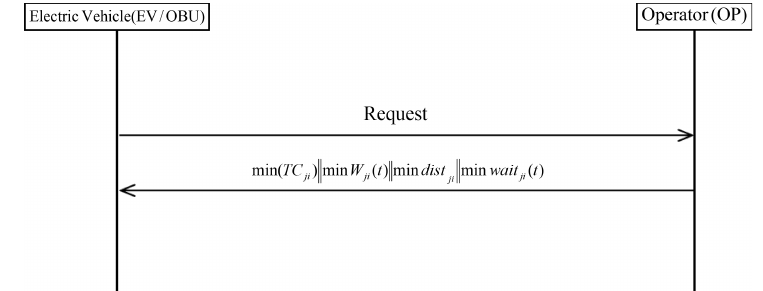
Figure 3. Scheduling phase of Huang et al.’s